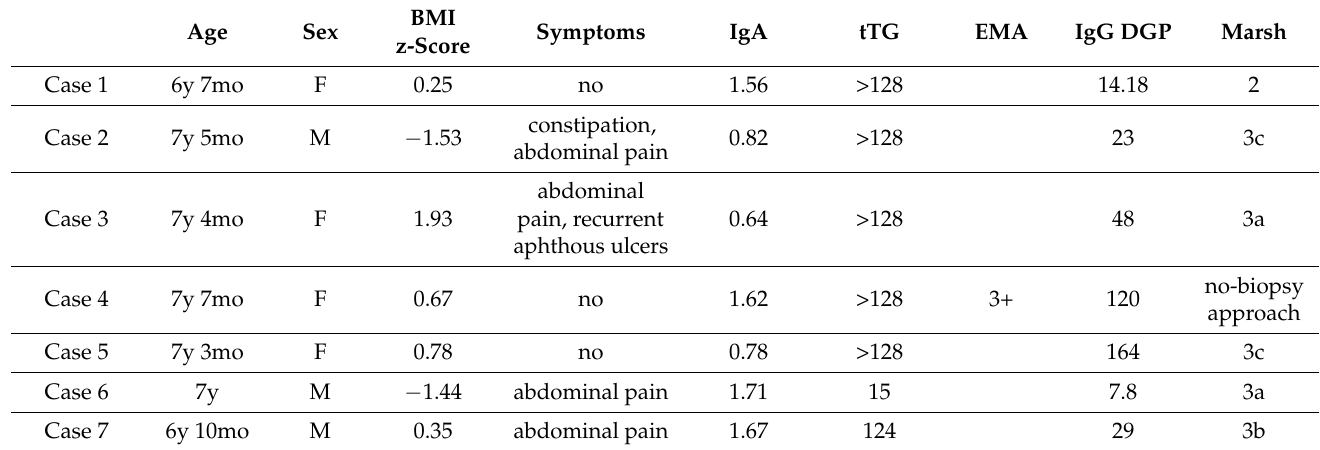
Table 1. Characteristics of children diagnosed with coeliac disease